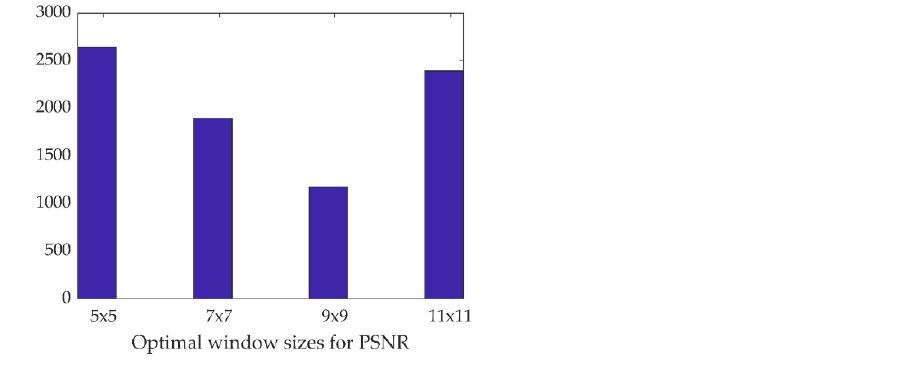
Figure 5. Numbers of test images with different optimal window sizes according to PSNR.